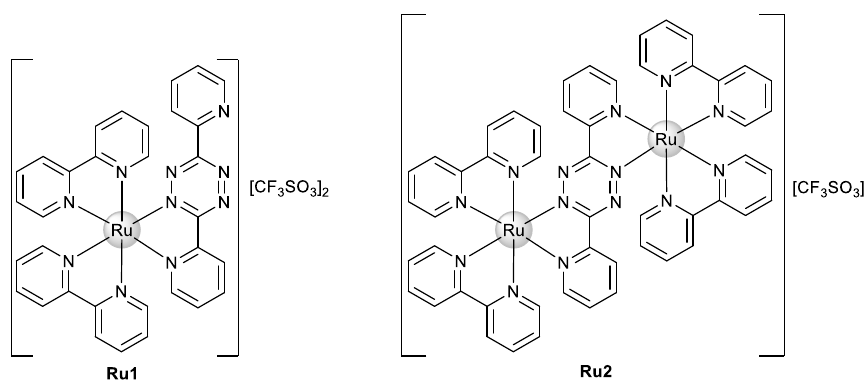
Figure 2. Chemical structure of Ru(II) – polypyridyl complexes Ru1 and Ru2 .